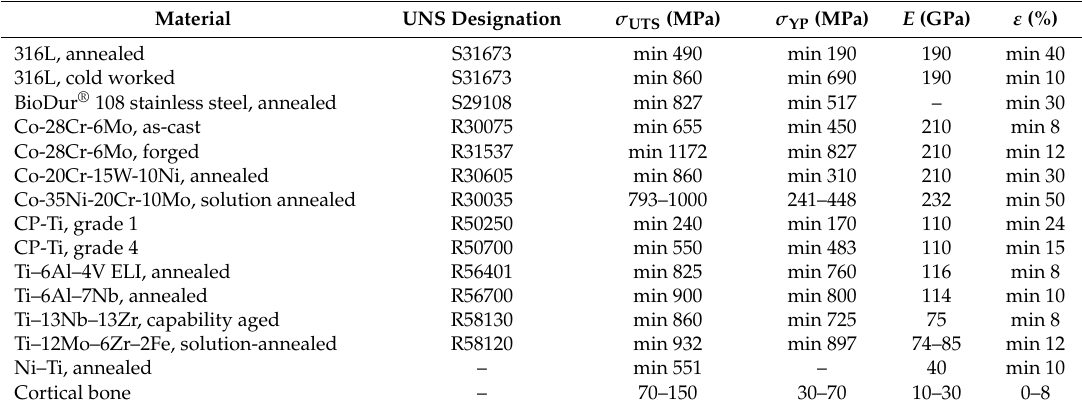
Table 7. Mechanical properties of selected